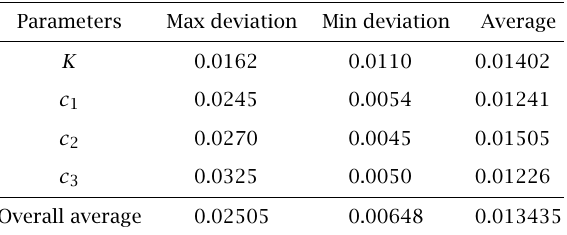
Table 3.2 . Average deviation of Problems II as a function of the parameters K , c 1 , c 2 , and c 3